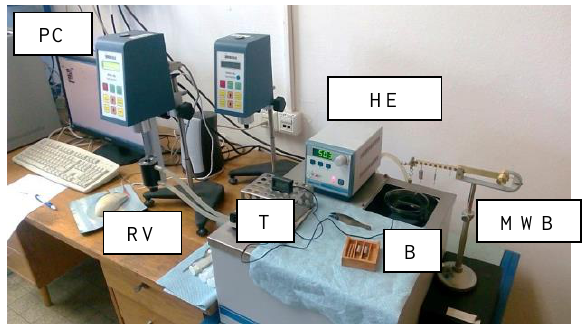
Fig. 1. Experimental measurements of the oil dynamic viscosity η and the oil density ρ The obtained viscous curve depending on the oil temperature t is shown in Figure 2.